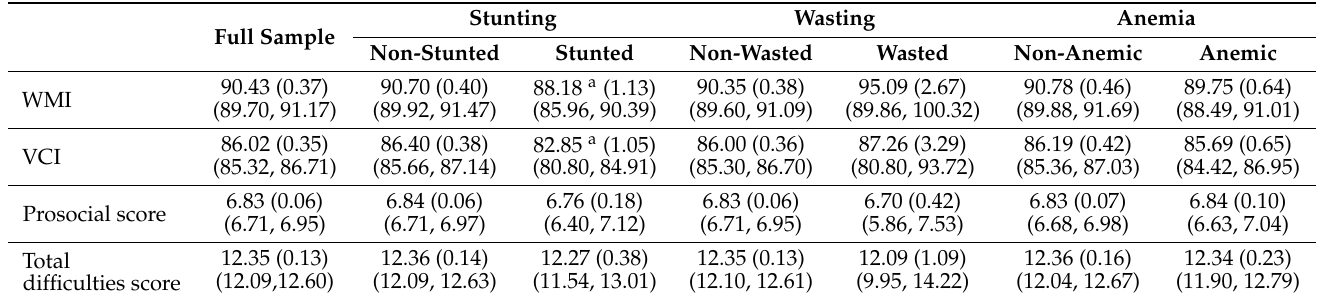
Table 3. Developmental outcomes by nutrition status. Values are mean (SD) (95% CI).